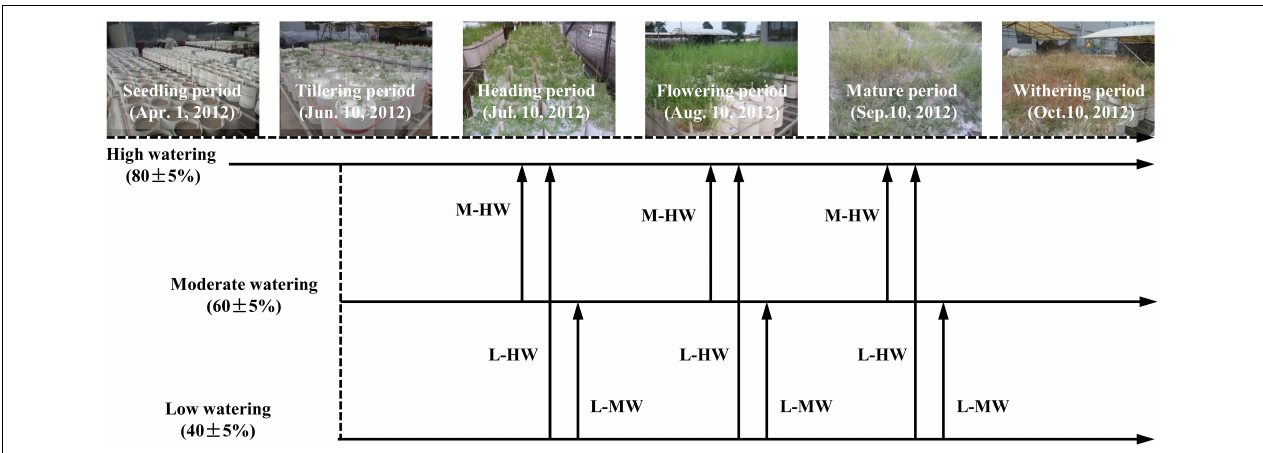
FIGURE 1 | The scheme of periodical soil watering treatments based on the growth periods of Bothriochloa ischaemum . High Watering (HW), 80 ± 5% pot soil capacity (FC); Moderate Watering (MW), 60 ± 5% FC; Low Watering (LW), 40 ± 5% FC. Moderate to high watering (M-HW), soil water contents increased from MW to HW regime; Low to moderate or high watering (L-MW or L-HW), soil water contents increased from LW to MW or HW regime, respectively.